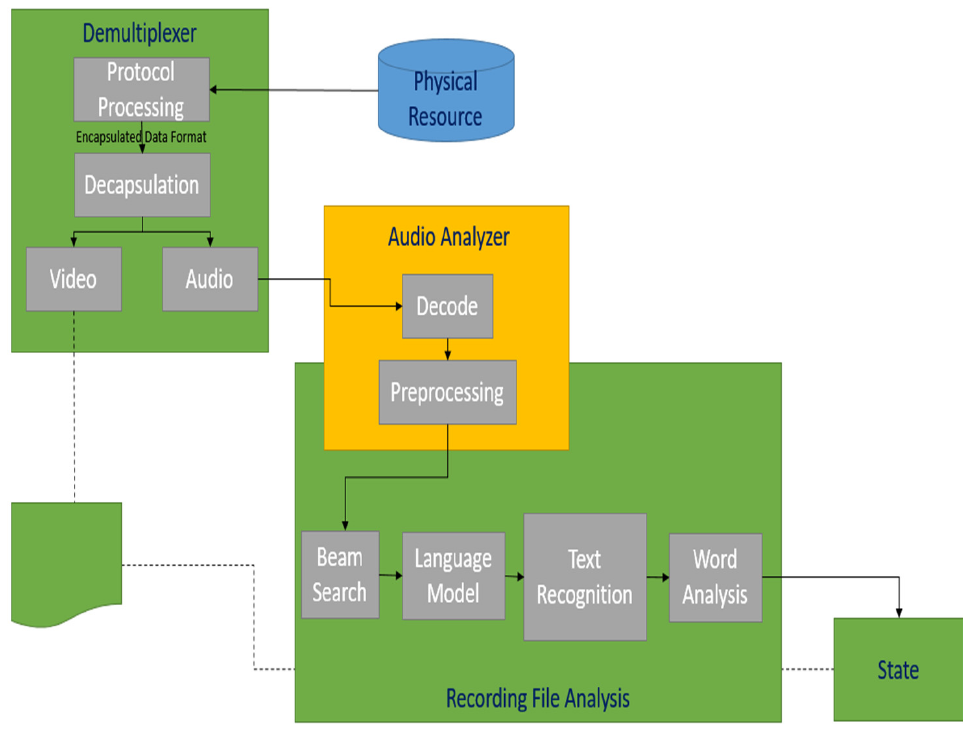
Figure 2. Recording file analysis flowchart.